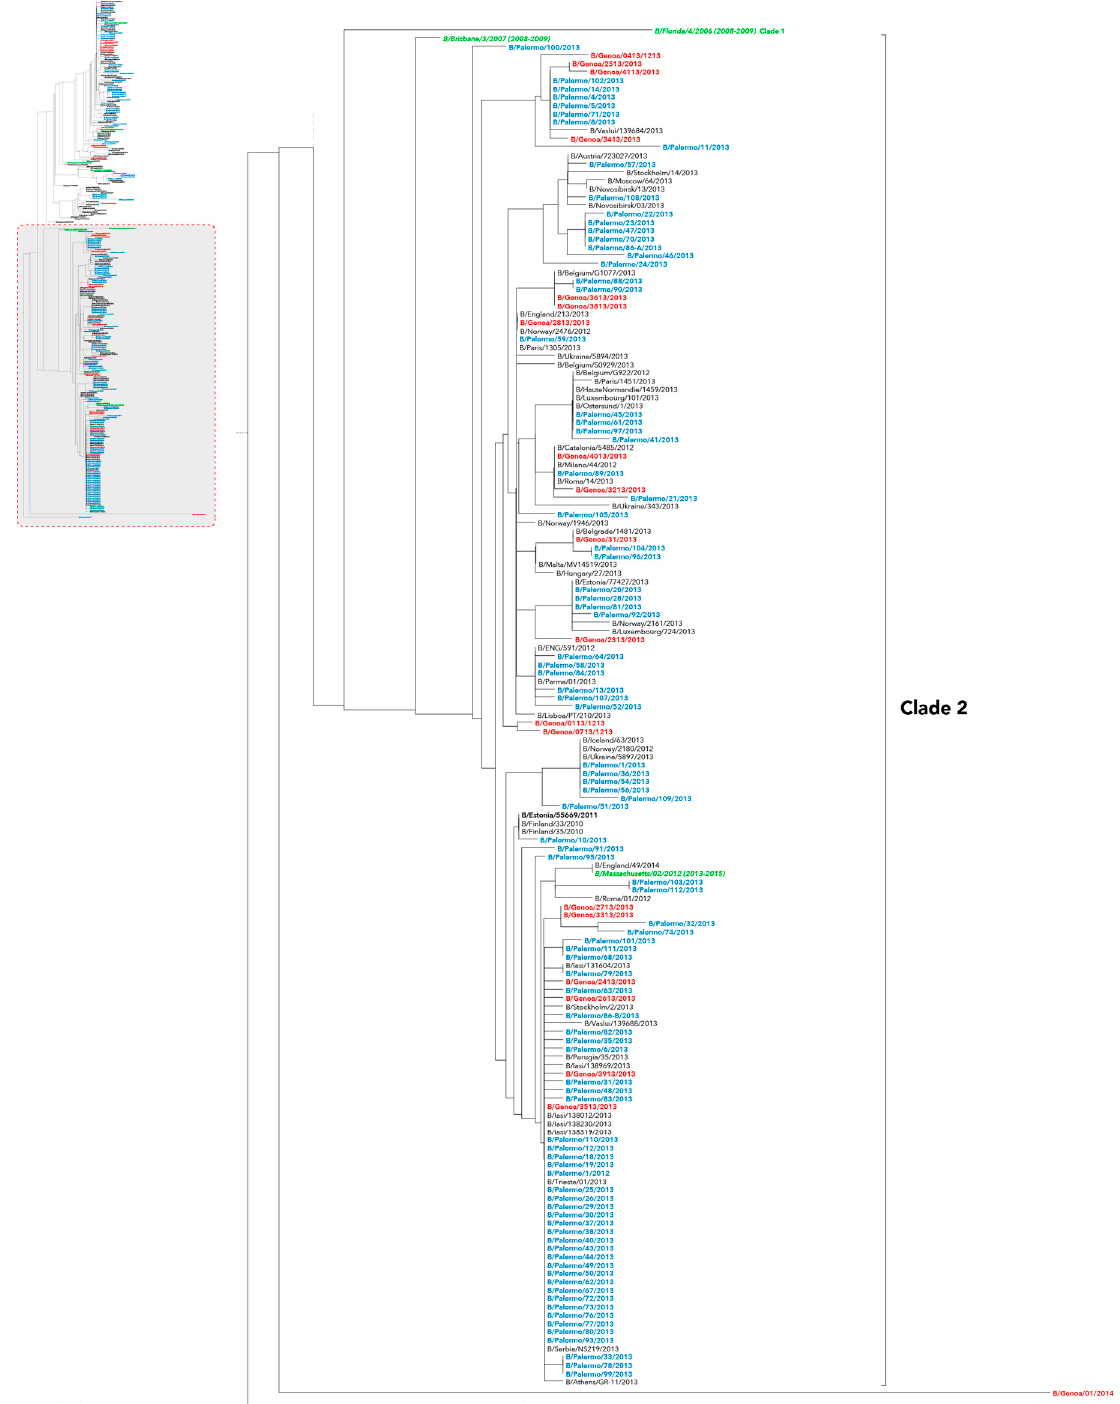
Figure 2. Phylogenetic analysis of the HA nucleotide sequences from influenza B Yamagata-lineage clade 2 viruses isolated in Italy from 2010 to 2015. The phylogeny tree was generated by the neighbor-joining method with 1000 bootstrap replicates. Sicilian strains (blue color), Ligurian strains (red color), WHO recommended candidate vaccine (green color) and reference strains (black color, bold font).